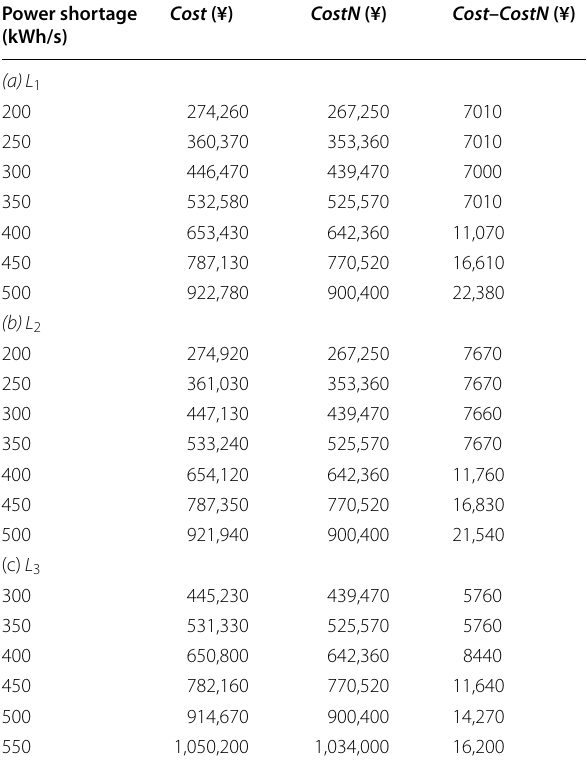
Table 8 Comparisons of the total costs between considering gas network constraints Cost and not considering gas